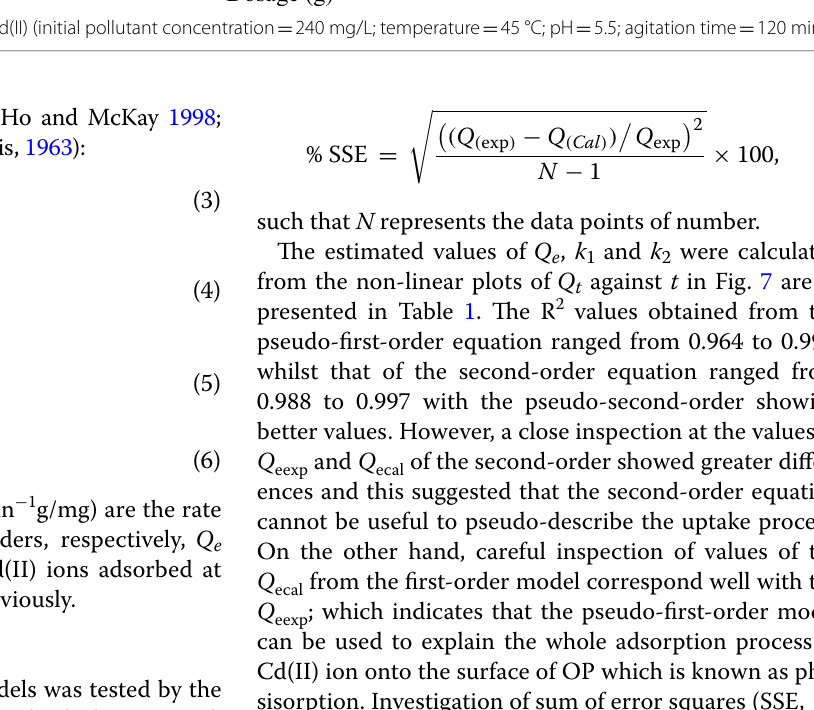
Fig. 6 Effects of dosage on adsorption of Cd(II) (initial pollutant concentration